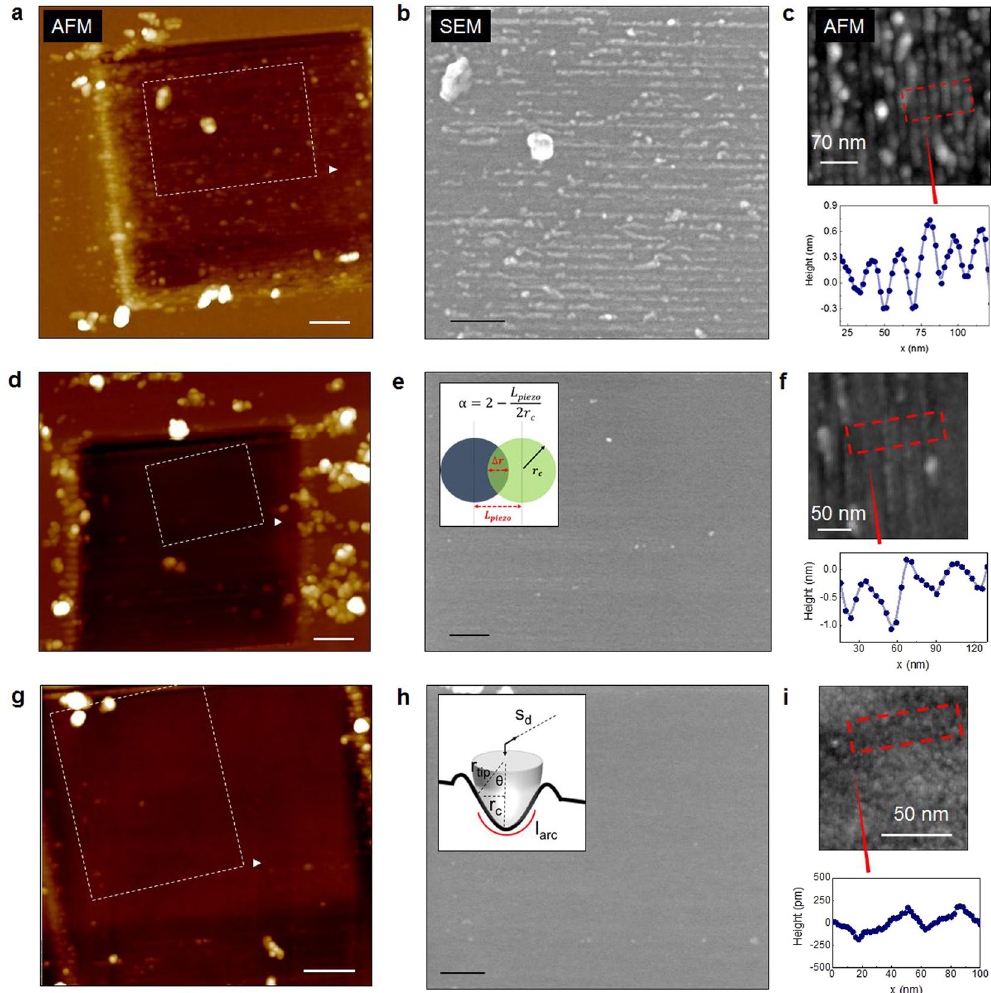
Figure 4. Impact of the material removal conditions on the surface quality of the machined area as studied by AFM and SEM. The same tip is used to scan three locations with the same load force and different line density ( a ) 128, ( d ) 256 and ( g ) 512 lines per image (scale bar 150 nm). The regions highlighted by a dashed box are imaged by SEM and shown in ( b ), ( e ) and ( h ), (scale bar 100 nm). 2D profiles are extracted using tapping mode AFM and are compared with the SEM images in ( c ), ( f ) and ( i ). Note, in the inset of ( e ) the geometrical considerations to calculate the overlap coefficient ( α ) are shown; while in the inset of ( h ) we show the details of the calculation for the deformed contact